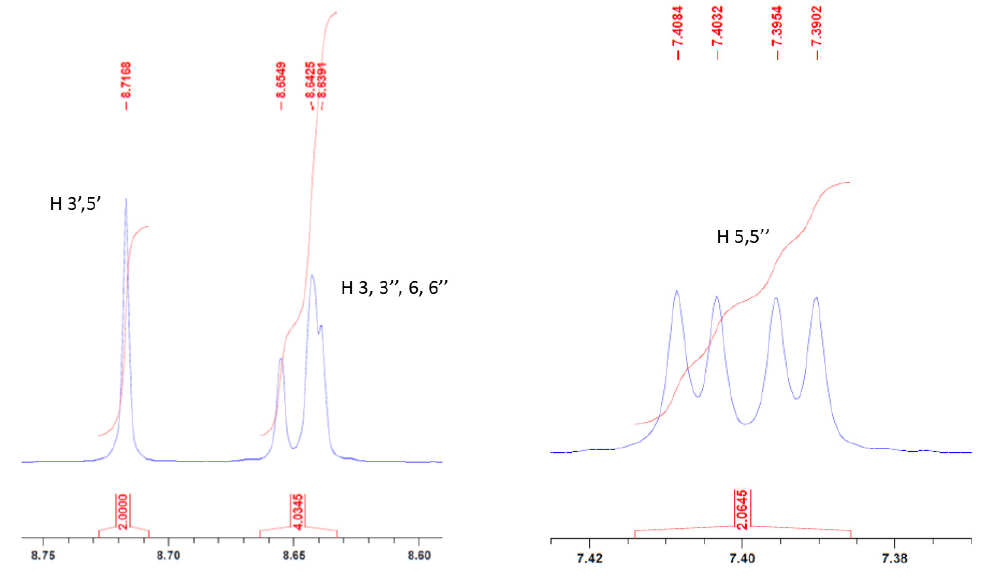
Figure 3. Part of NMR spectrum showing signals for protons (3 ′ ,5 ′ ), (3,3 ′′ ,6 ′ ,6 ′′ ), and (5,5 ′′ ).